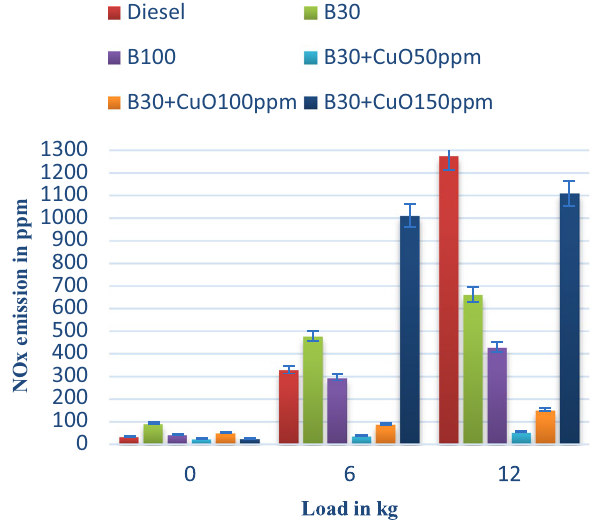
Fig. 5 Effect of Load on NOx emission in ppm of blends consisting diesel and WCO biodiesel with CuO nanodopes